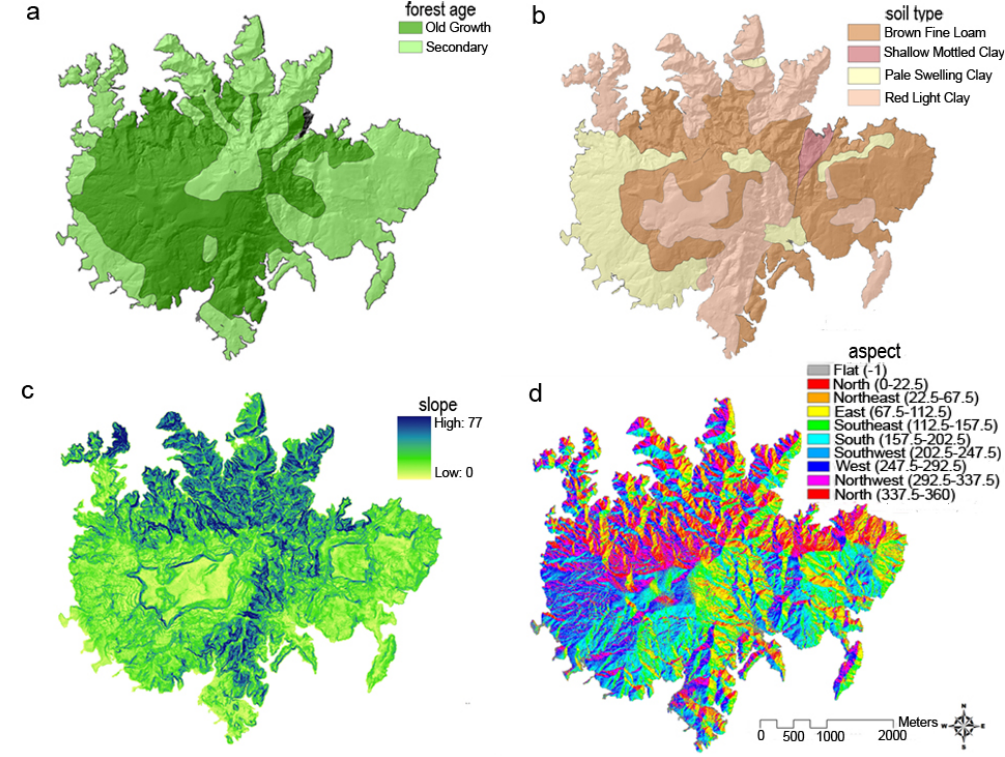
Fig. 1. Spatial distribution of environmental variables with the potential to influence the pattern of gap disturbance across Barro Colorado Island: (a) forest age, (b) soil type, (c) slope, and (d) aspect.